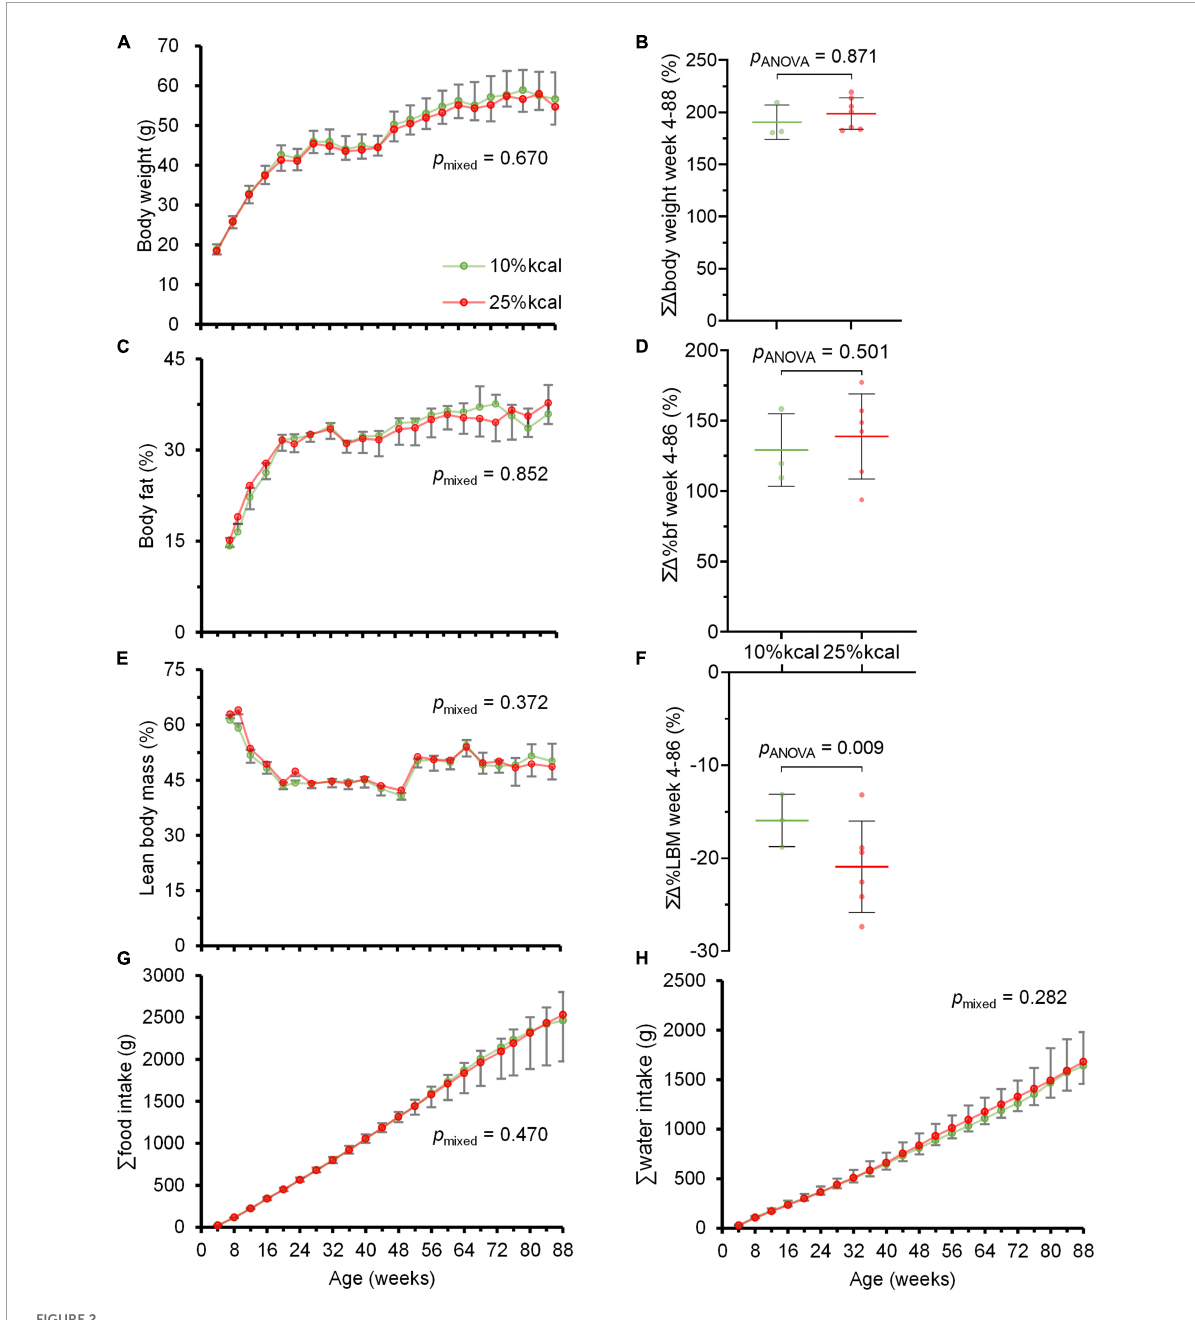
FIGURE2 Chronic higher added sugars intake does not lead to overweight and obesity in male C57BL/6N mice. (A) Body weight (g); (B) cumulative change in body weight (%); (C) body fat (%); (D) cumulative change in body fat (%); (E) lean body mass (%); (F) cumulative change in lean body mass (%); (G) cumulative food intake (g); and (H) cumulative water intake (g) of male C57BL/6N ( n = 10 in each group at the start, see Supplementary Tables 1 , 2 for n at each timepoint) fed 10 vs. 25% kcal sucrose diets between weeks 4 and 88. Values are presented as mean ± SD. Differences between groups were tested using linear mixed model for time-series analysis, and one-way ANOVA for single timepoint analysis. Although the study ended at week 104, only data until week 88 were plotted as the study mice were losing weight due to aging and other ailments rather than the study